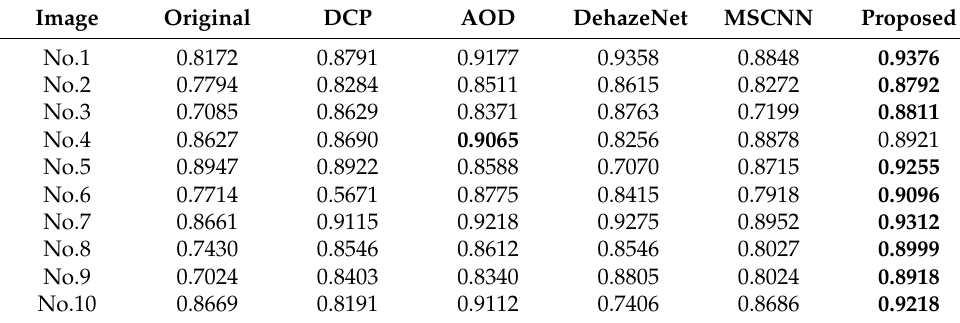
Table 3. Evaluation of processed images by